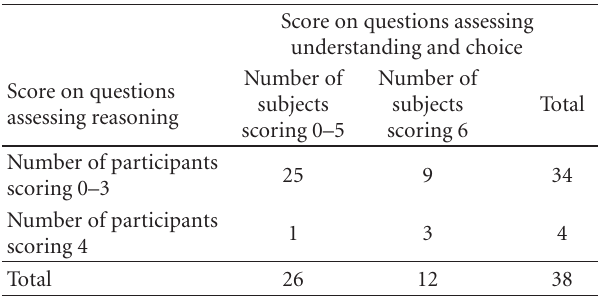
Table 3: Cross-tabulation relating scores on understanding and making a choice to scores on reasoning.